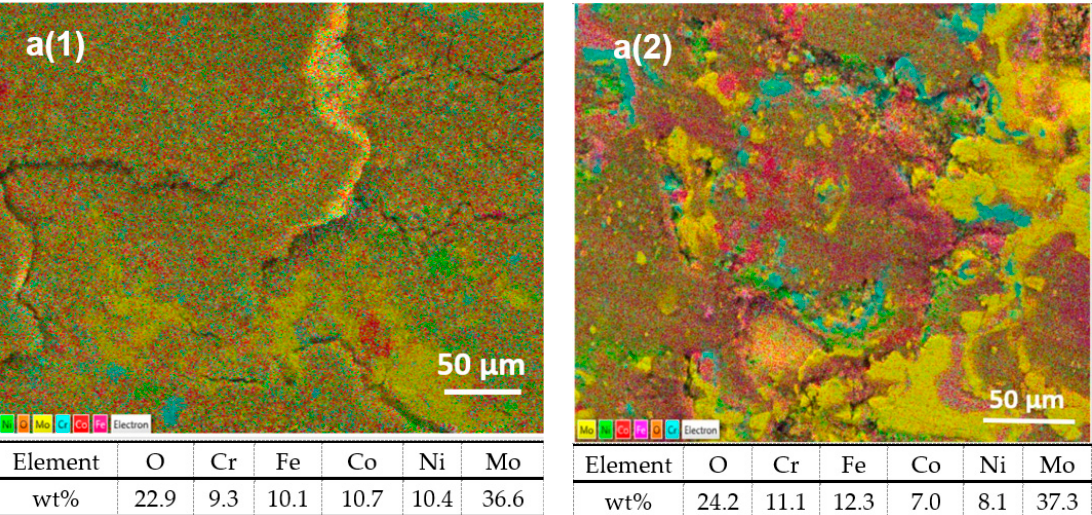
Figure 14. EDX mapping results ( a ) of the layer formed on the ( a1 ) HVOF-HEA_Mo 27 and ( a2 ) HVOF-HEA_Mo 20 as-sprayed coatings after 12,000 wear cycles under dry test condition.